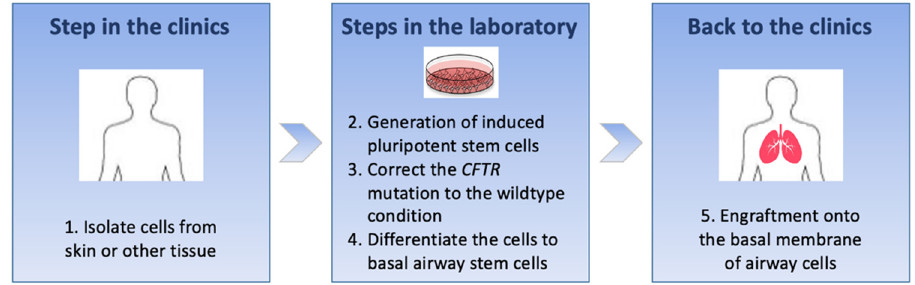
Figure 2. Main steps for cell-based therapy in cystic fibrosis: it is an ex vivo approach wherein patient’s cells are collected and modified in vitro to obtain corrected basal airway stem cells and then transferred back into the patient.